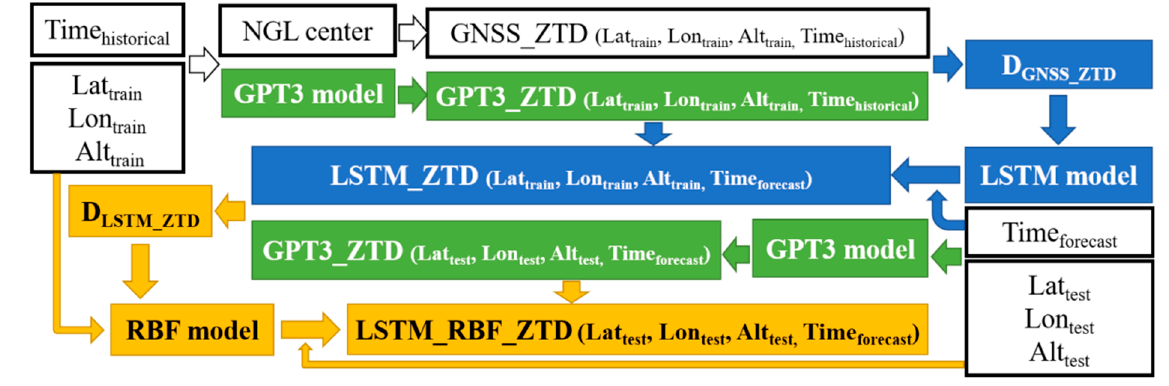
Figure 8. Flow diagram of the experiment.